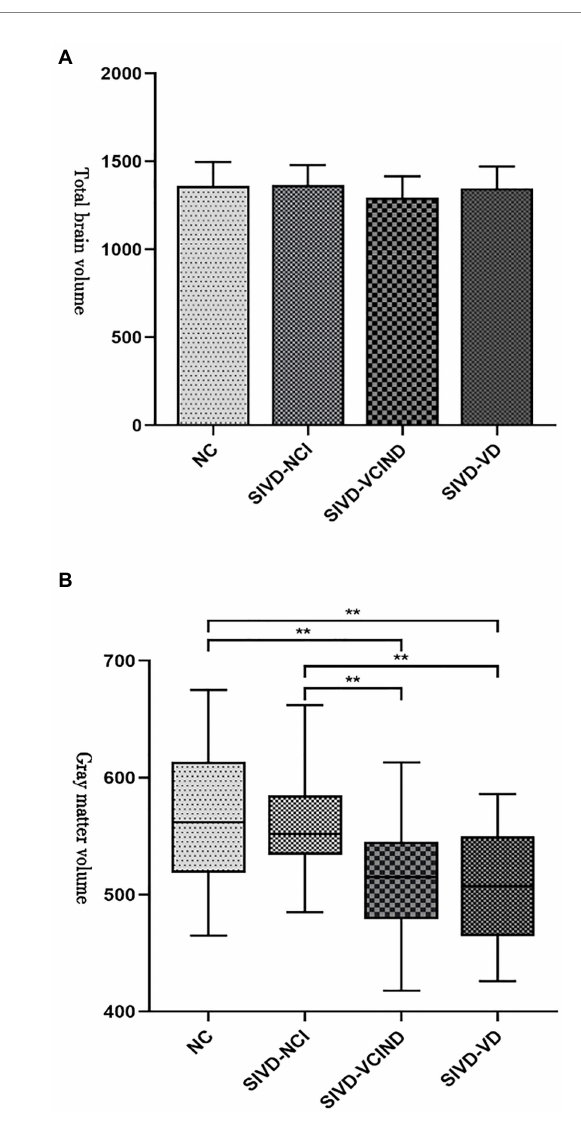
FIGURE 1 (A, B) Analysis results of total craniocerebral and gray matter volumes among the four groups. “**” indicate p < 0.01.